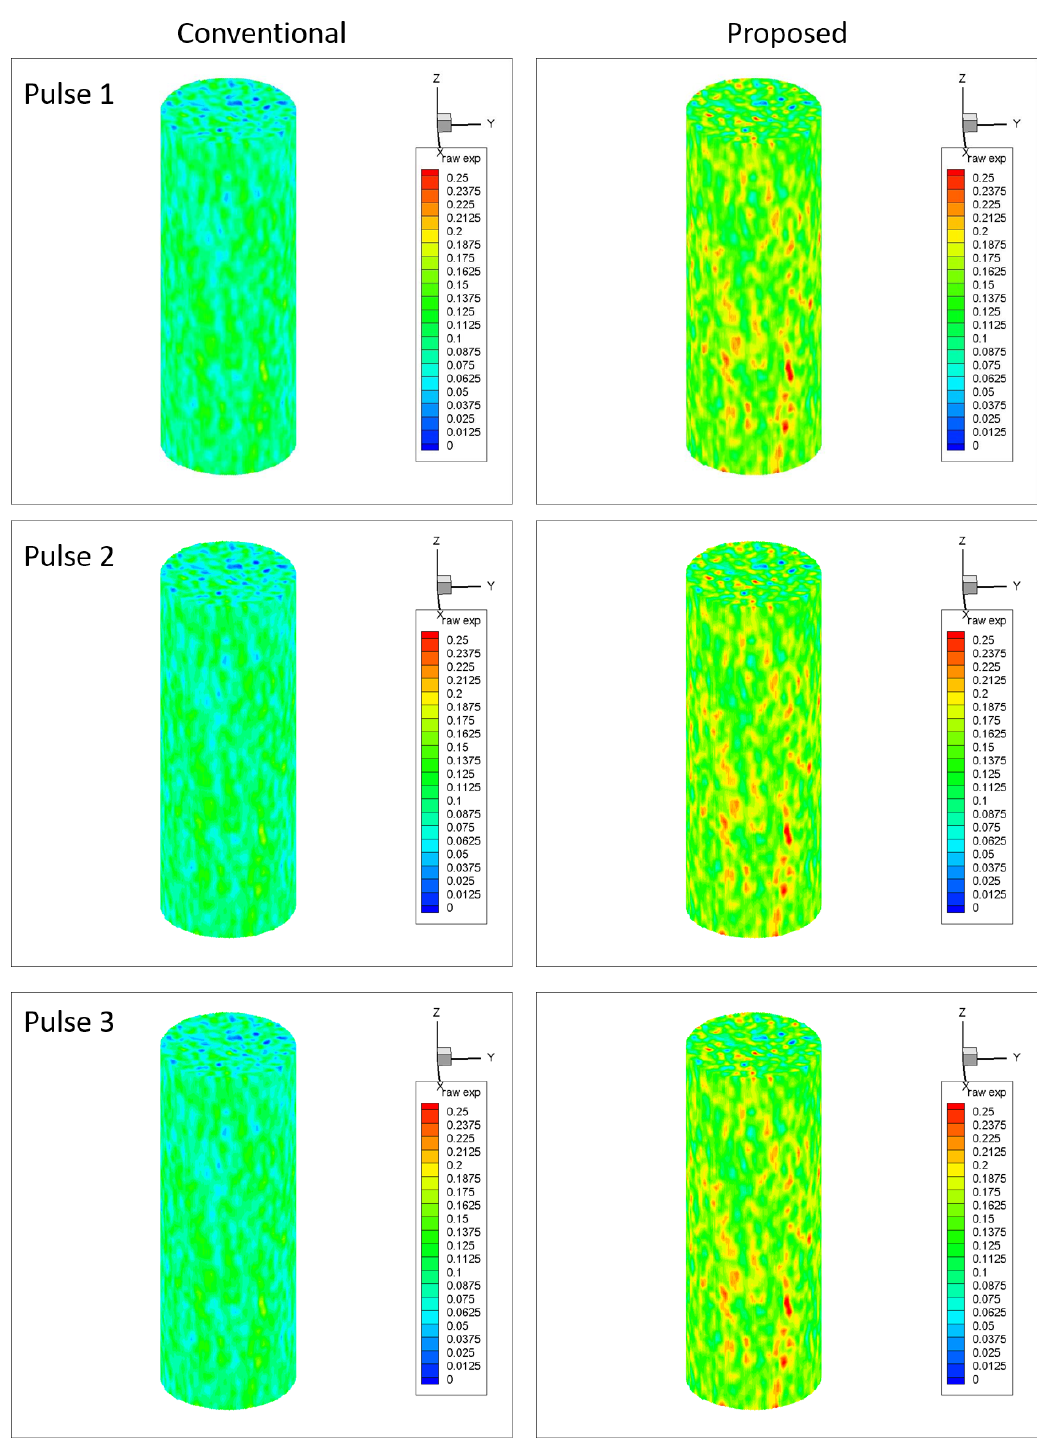
Figure 8. 3D CT images of Kr apparent porosity for the three pressure pulses conducted on the Wolfcamp sample. Local areas with relatively greater storage are consistent in both methods; however, the magnitude by which Kr stores in these areas